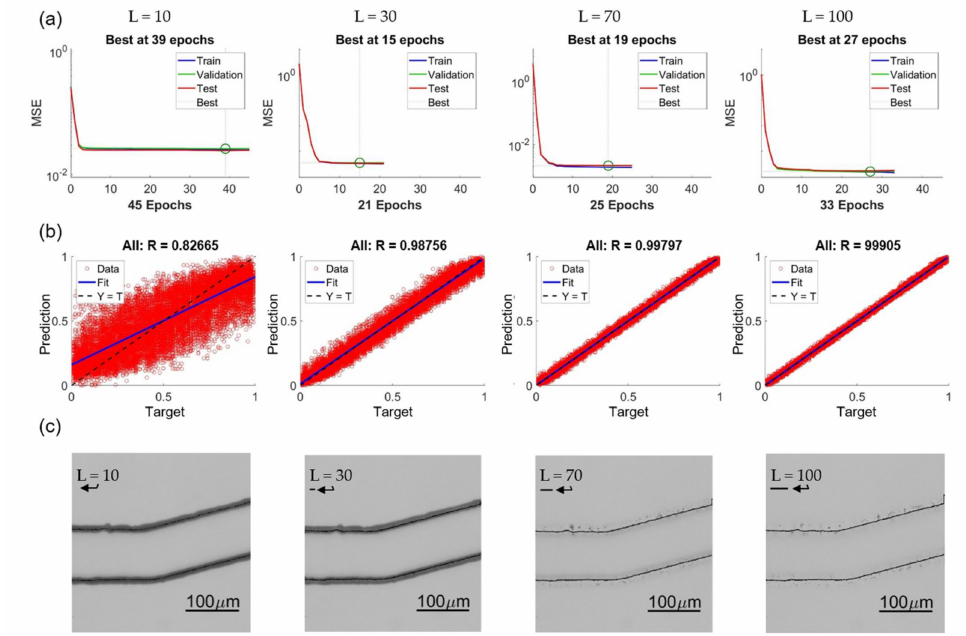
Figure 15. Effects of different feature lengths L. ( a ) Training convergence. ( b ) Regression plots. ( c ) Enhanced images.